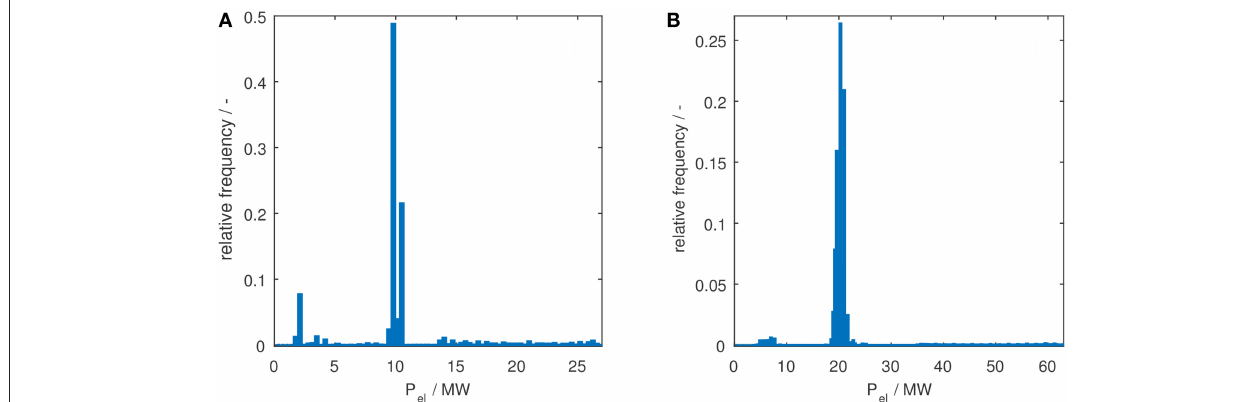
FIGURE 4 | Histograms of the flight data of the A320 (A) , and the B772 (B) .